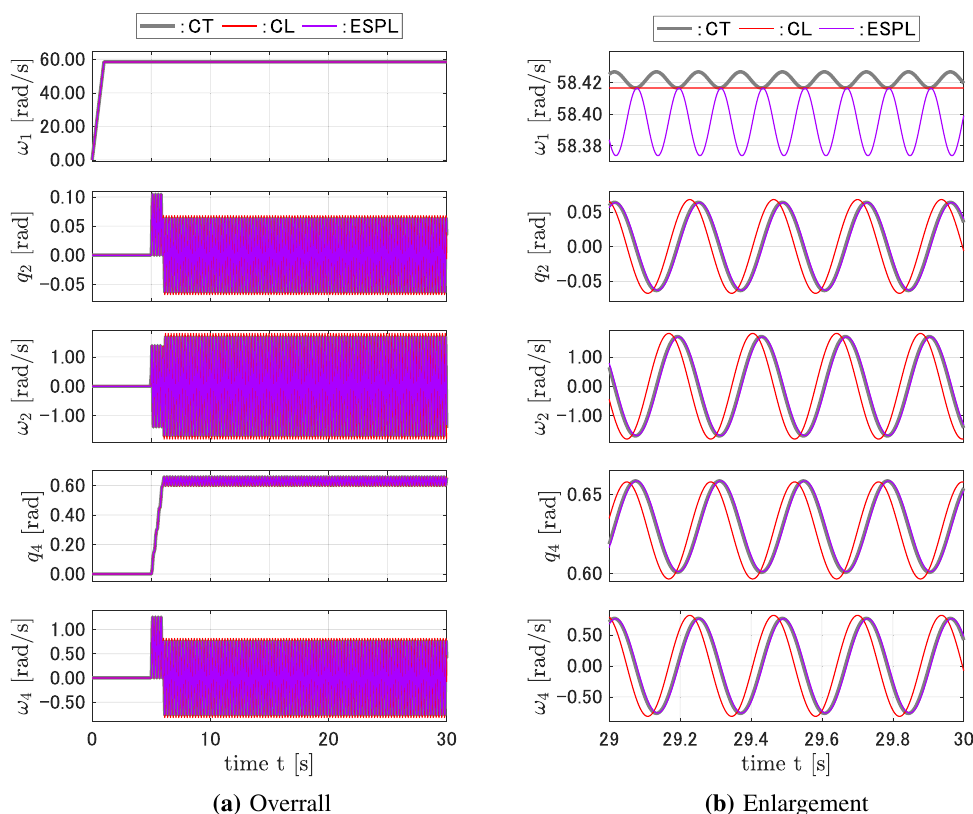
Figure 7. Responses of the CT, CL, and ESPL models for the (relatively) exact